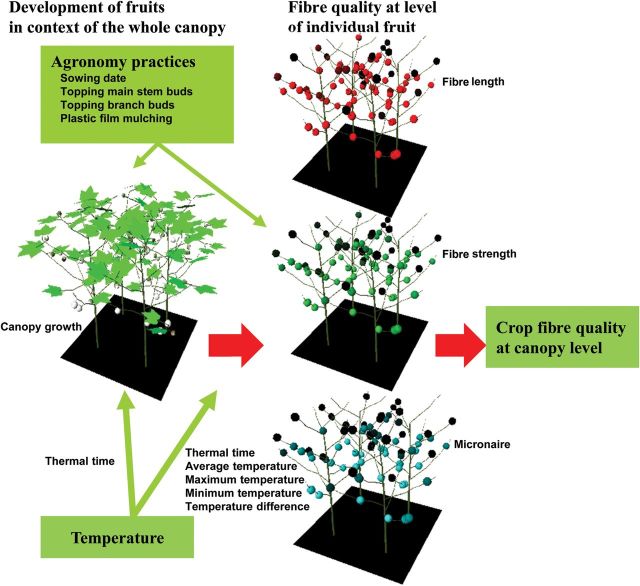
Illustration of the model concepts. At the level of the fruit, fibre quality (length, strength and micronaire) is calculated as determined by temperature (daily average, maximum, minimum and difference between maximum and minimum temperatures). Whole plant development is also driven by temperature, and is further determined by sowing date, topping and soil film cover. Output of the model includes distribution of cotton boll development within the plant and over time, as well as fibre quality of all individual bolls. Fibre quality aspects of length, strength and micronaire, with colour intensity represents the value (dark = low, bright = high).